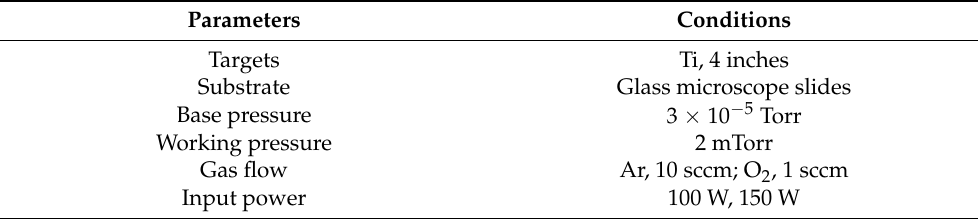
Table 1. Sputtering conditions.